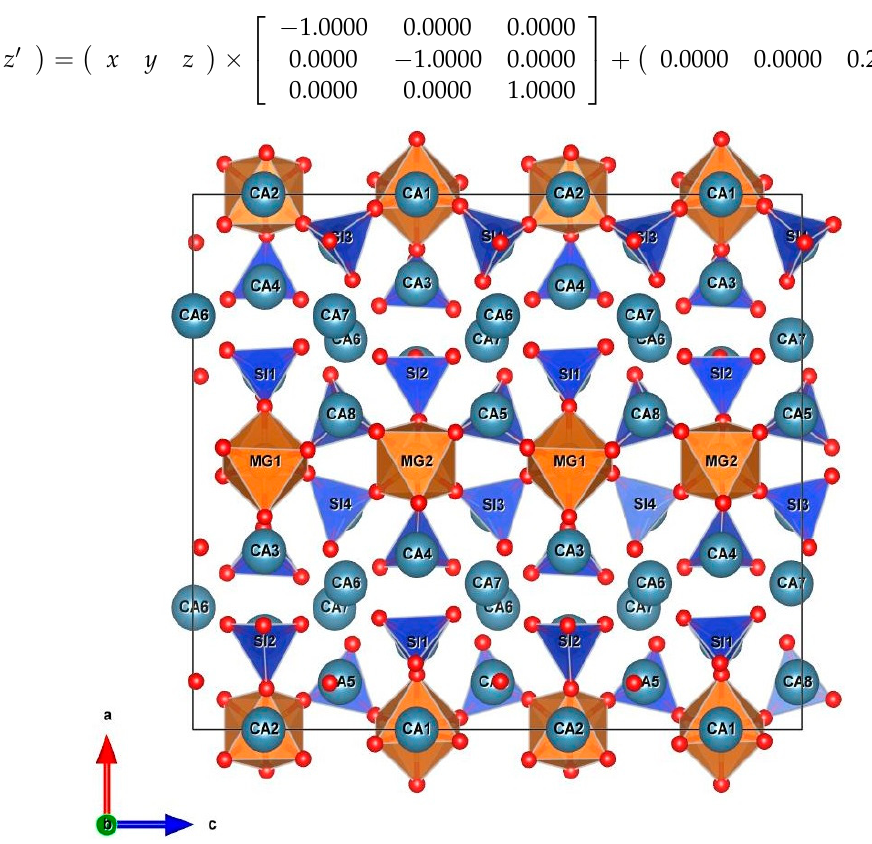
Figure 3. Polyhedral view of Bre structure in space group Pnn 2 .